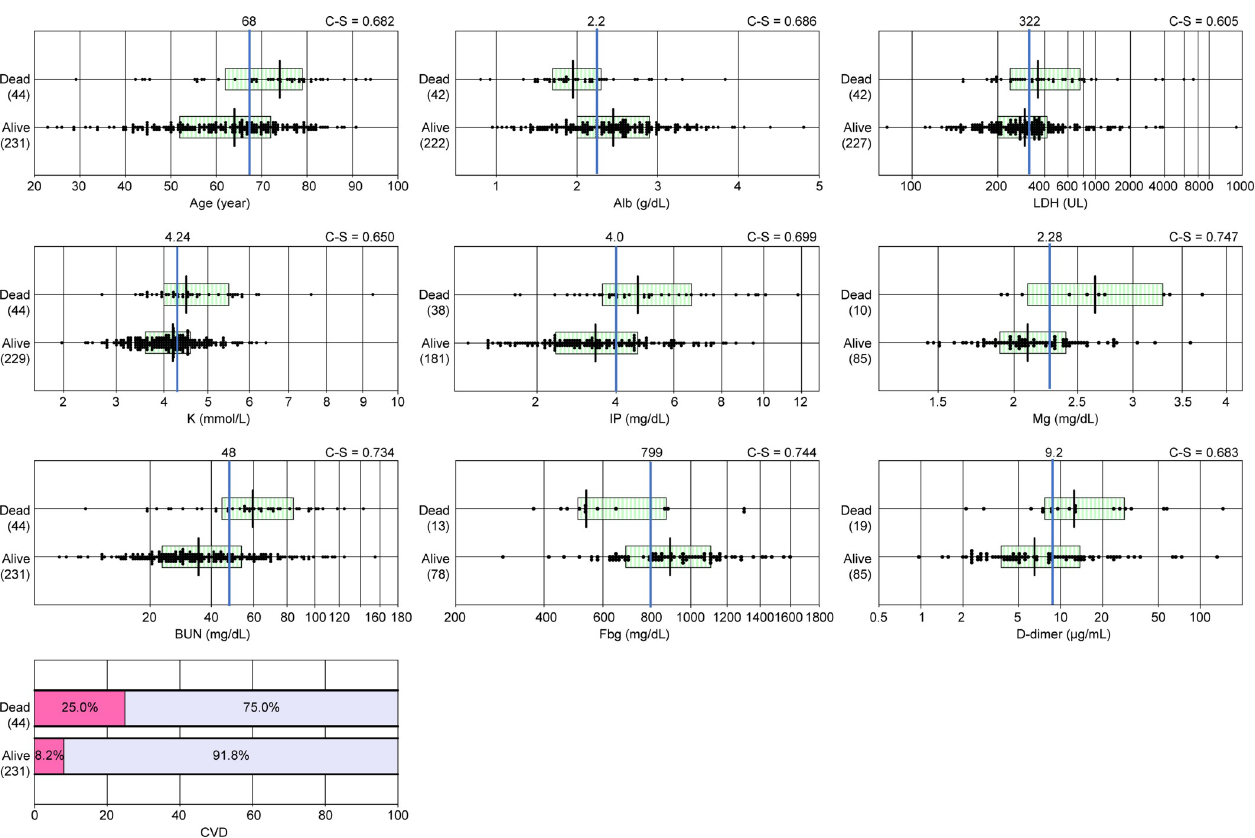
Fig 2. Comparison of 10 major risk variables in relation to the outcome. Patients with CRP levels � 40 mg/dL (S1 Dataset) were divided by 72-hour outcome (44 dead and 218 alive). The utility of each risk variable for distinguishing the two groups was calculated as C-statistics (C-S) by ROC analysis. The cutoff value for the distinction (shown by the vertical line in the center) was determined as a value where the sensitivity is equal to the specificity.